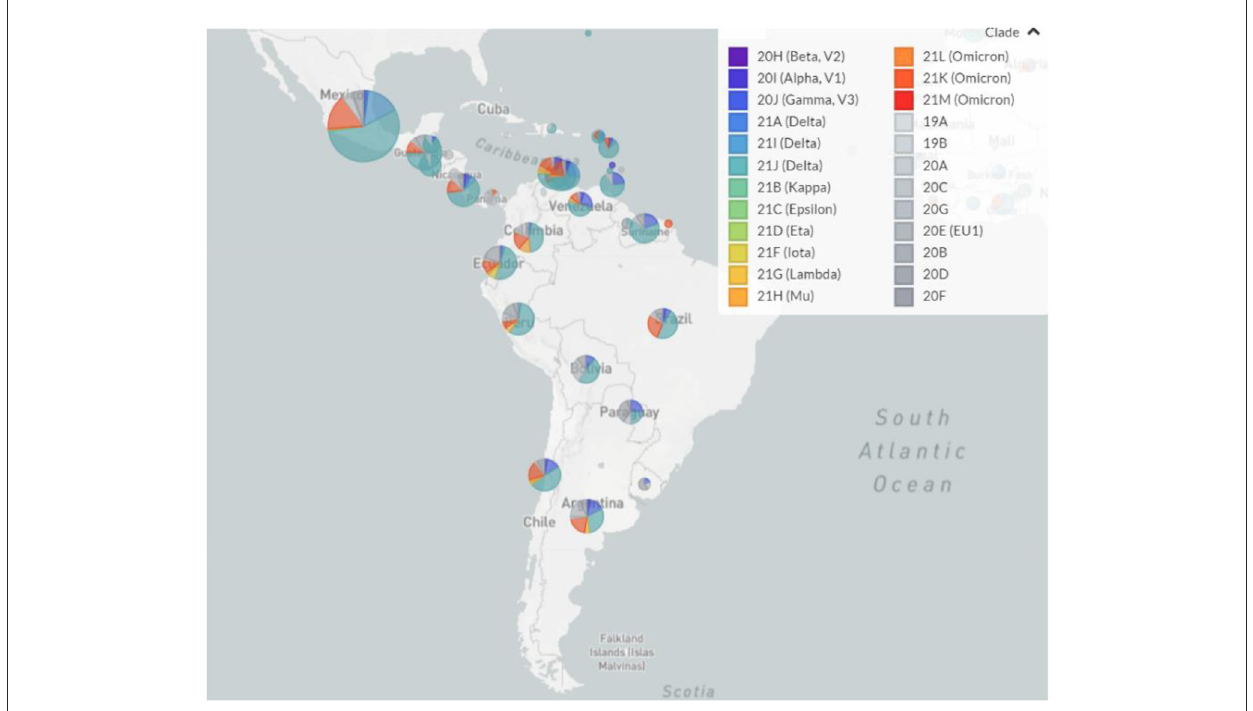
FIGURE1 Landscape of the SARS-CoV-2 genotypes circulating in Latin America from February 2021 to January 2022. Pie charts indicate the relative abundance of distinct SARS-CoV-2 genotypes in each country.